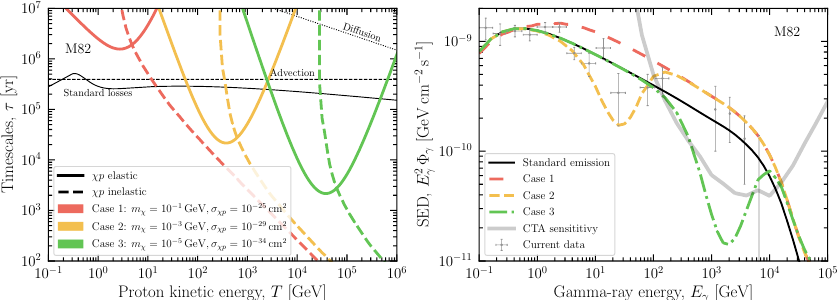
Figure 4. Left Panel The comparison between the standard timescales (losses, advection and di ff usion) in black lines and three di ff erent cases regarding m χ and σ χ p . Please be careful that in this figure the losses timescales are divided by α − 3 [6]. Right Panel The corresponding theoretical expected gamma-ray fluxes for the source compared with the experimental Fermi-LAT and VERITAS data [7, 9]. Image taken from Ref.